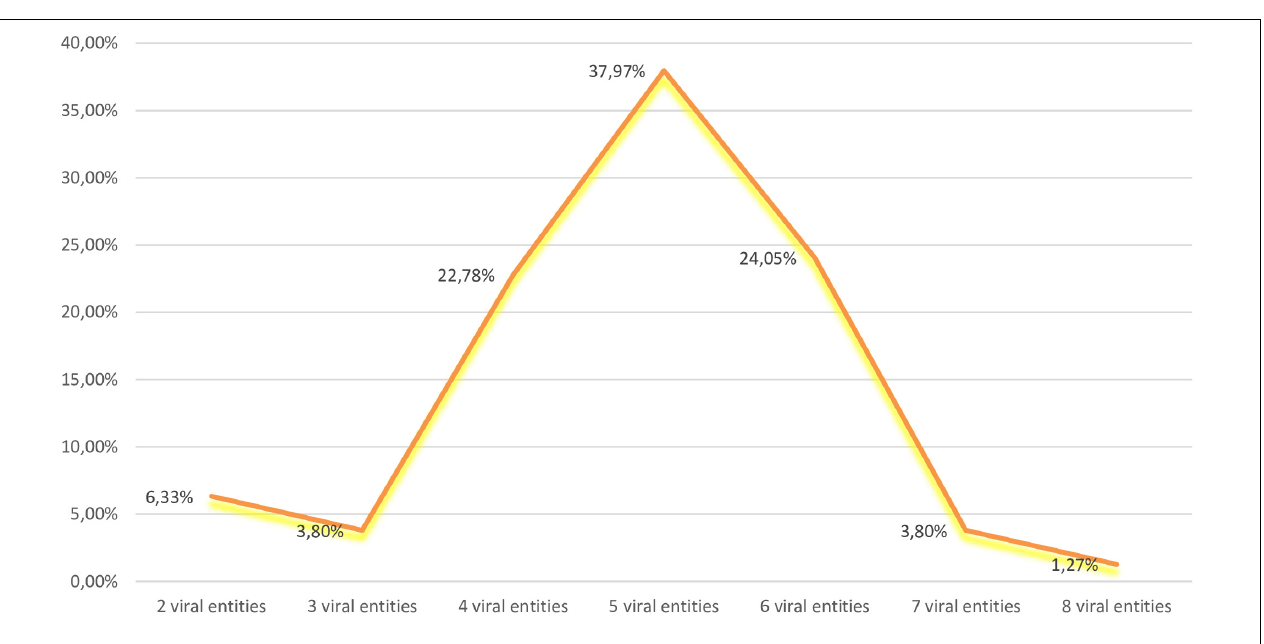
FIGURE 3 | Percentages of mixed infections in analyzed